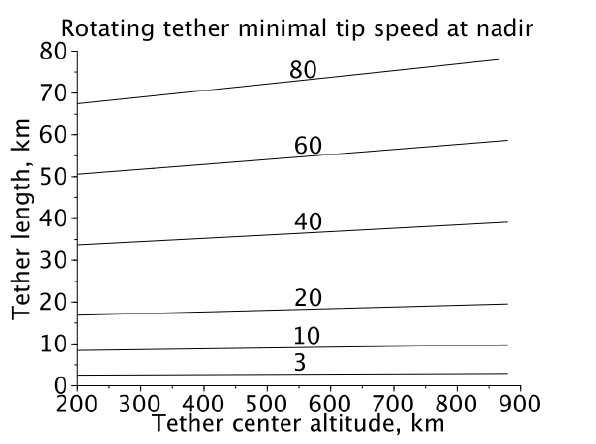
Figure 6. The minimal nadir speed of the tether tip relative to the tether center of mass to sustain tether